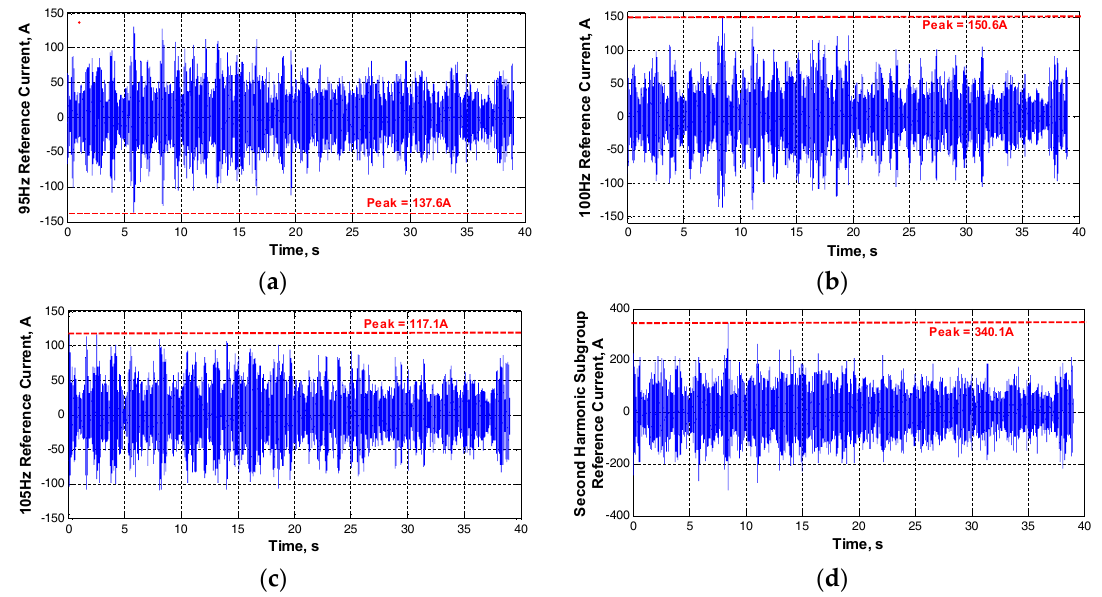
Figure 6. A sample set of EAF current waveforms obtained by MSRF analysis in real-time ( a ) 95-Hz, ( b ) 100-Hz, ( c ) 105-Hz components, and ( d ) the reference current signal produced from ( a – c ).